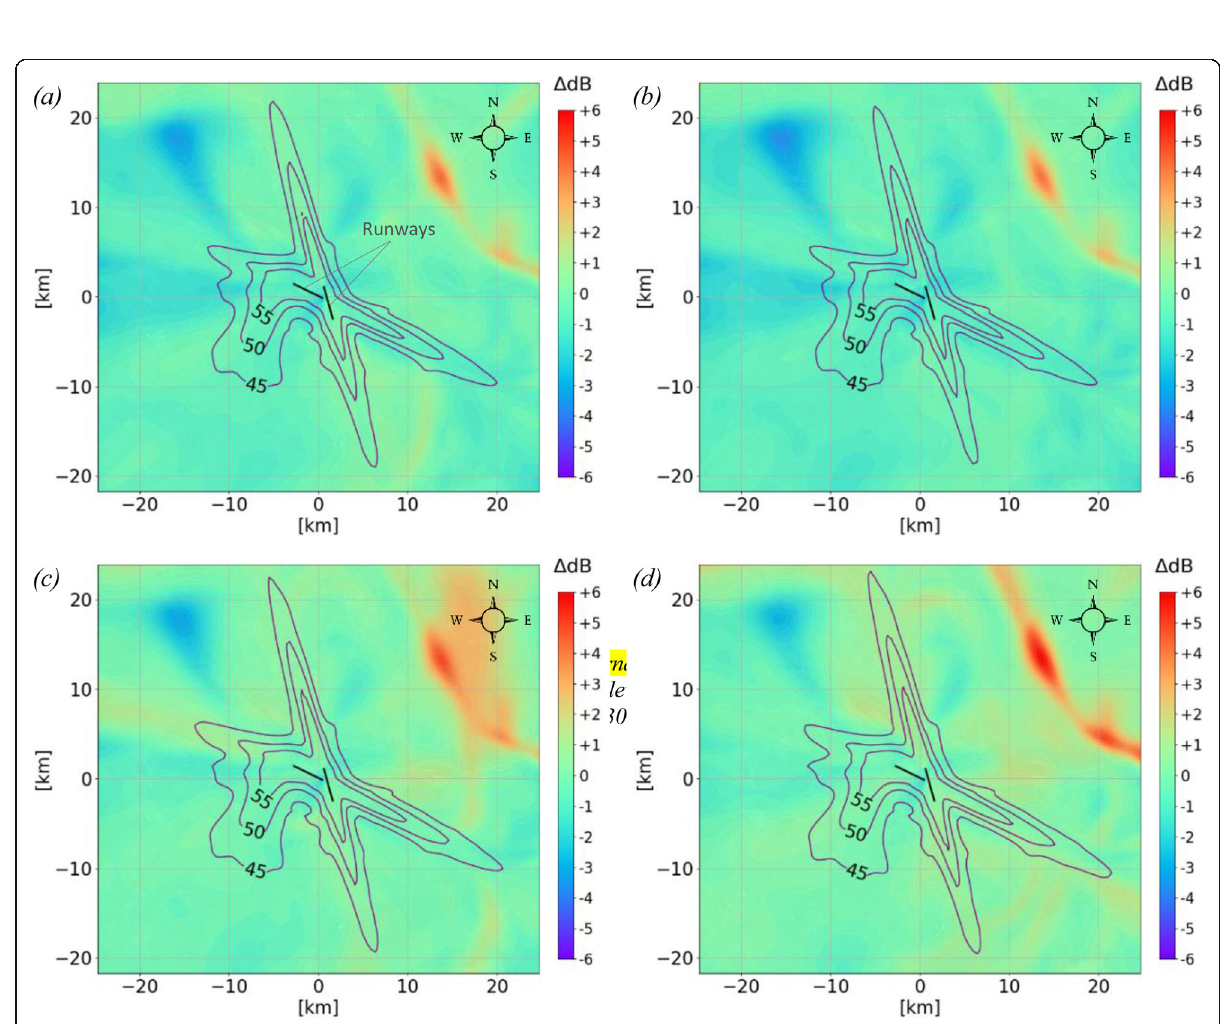
Fig. 8 Maps of predicted variations in L DEN from 2018 to 2025, and 2025 L DEN contours at Vienna International Airport for ( a ) unaltered traffic volume, ( b ) low increase, ( c ) baseline increase, ( d ) high increase ( Δ dB = L DEN,2025 – L DEN,2018 ). Fleet substitution is applied in all the four